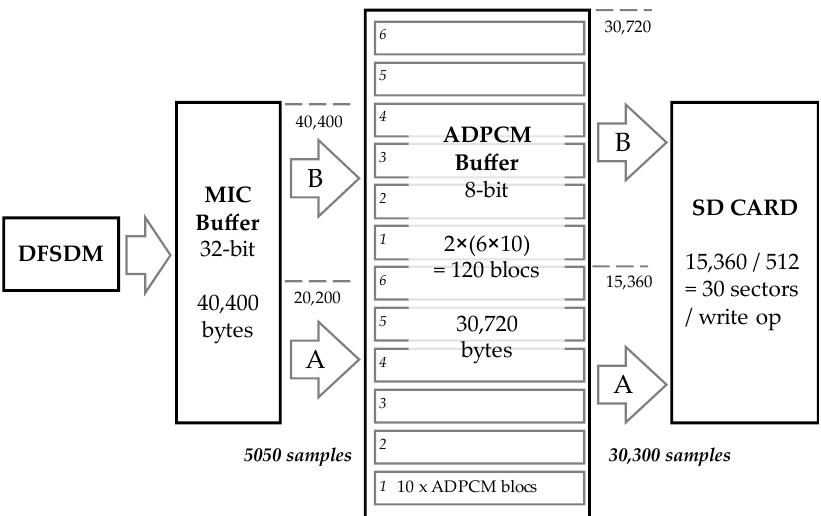
Figure 6. Audio data buffering scheme.